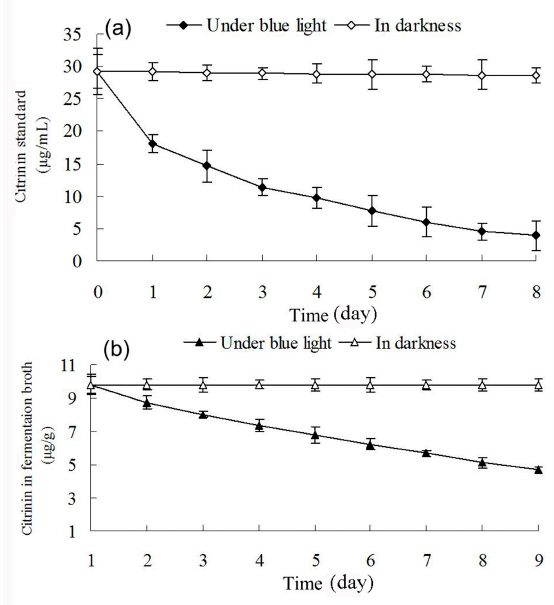
Figure 8. Effects of blue light on the stabilities of citrinin standard ( a ) and citrinin in fermentation broth ( b ). Citrinin standard methanol solution and citrinin of Monascus fermentation ethanol extraction were respectively exposed to blue light and kept in darkness. Citrinin content was determined by HPLC at specific time intervals.